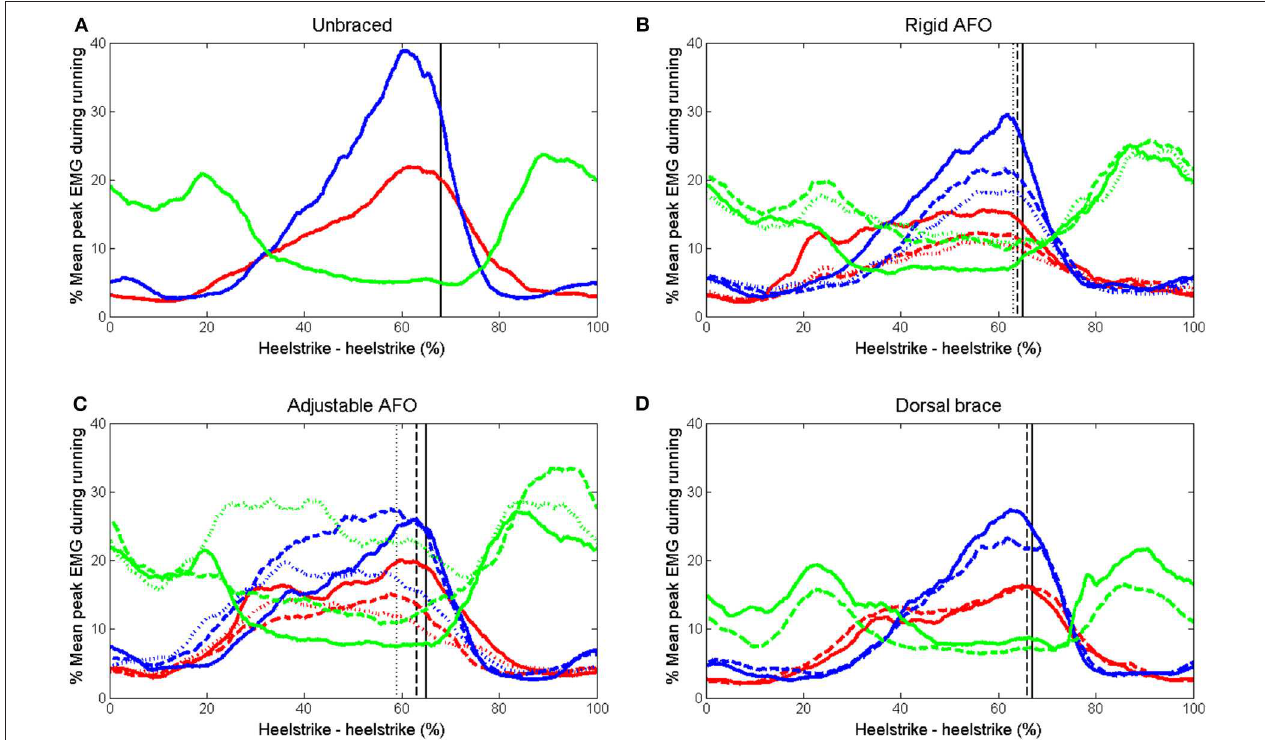
FIGURE 4 | Mean EMG curves for medial gastrocnemius (blue), soleus (red), and tibialis anterior (green) during walking. (A) unbraced walking (B) rigid AFO with 0 wedges (solid), 2 wedges (dashed), and 3 wedges (dotted). (C) adjustable AFO with ankle dorsiflexion limited to 10 ◦ dorsiflexion (solid), 10 ◦ plantarflexion (dashed), and 30 ◦ plantarflexion (dotted) (D) dorsal brace with 0 wedges (solid) and 1 wedge (dashed). Toe off time is indicated for each setting by a vertical line with the corresponding line format.